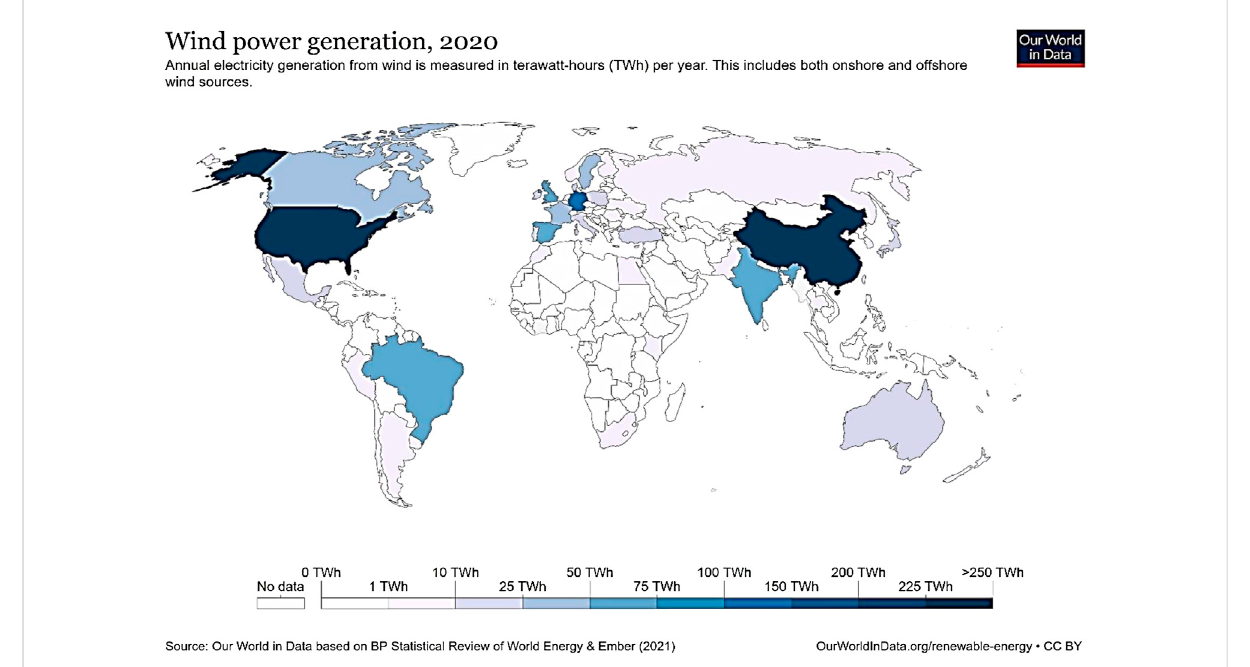
FIGURE 1 Overall wind power generation